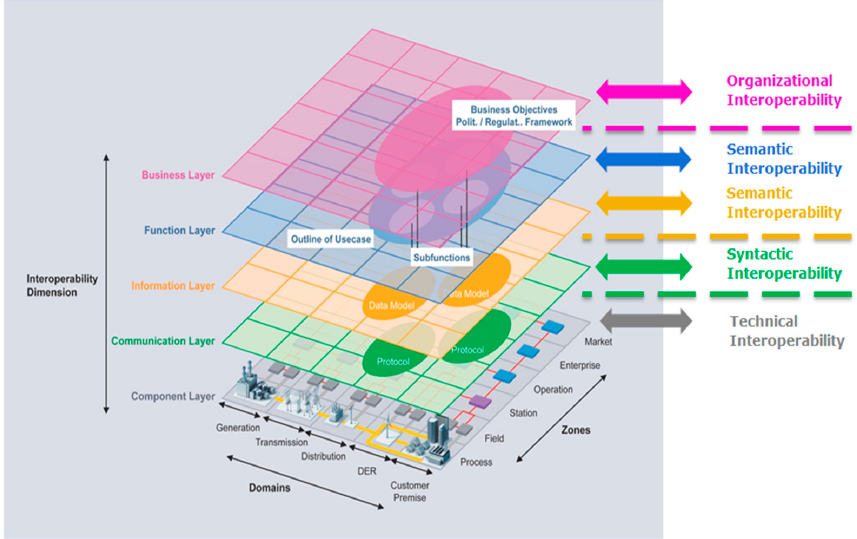
Figure 1. SGAM model and Interoperability Types, as extracted by reference [7].